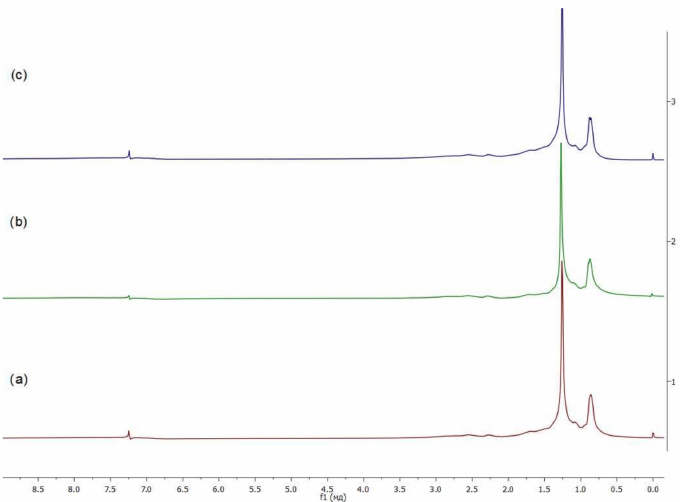
Figure 9. 1 H NMR spectra of the bitumen ( a ), tar ( b ) and the compounded bitumen ( c